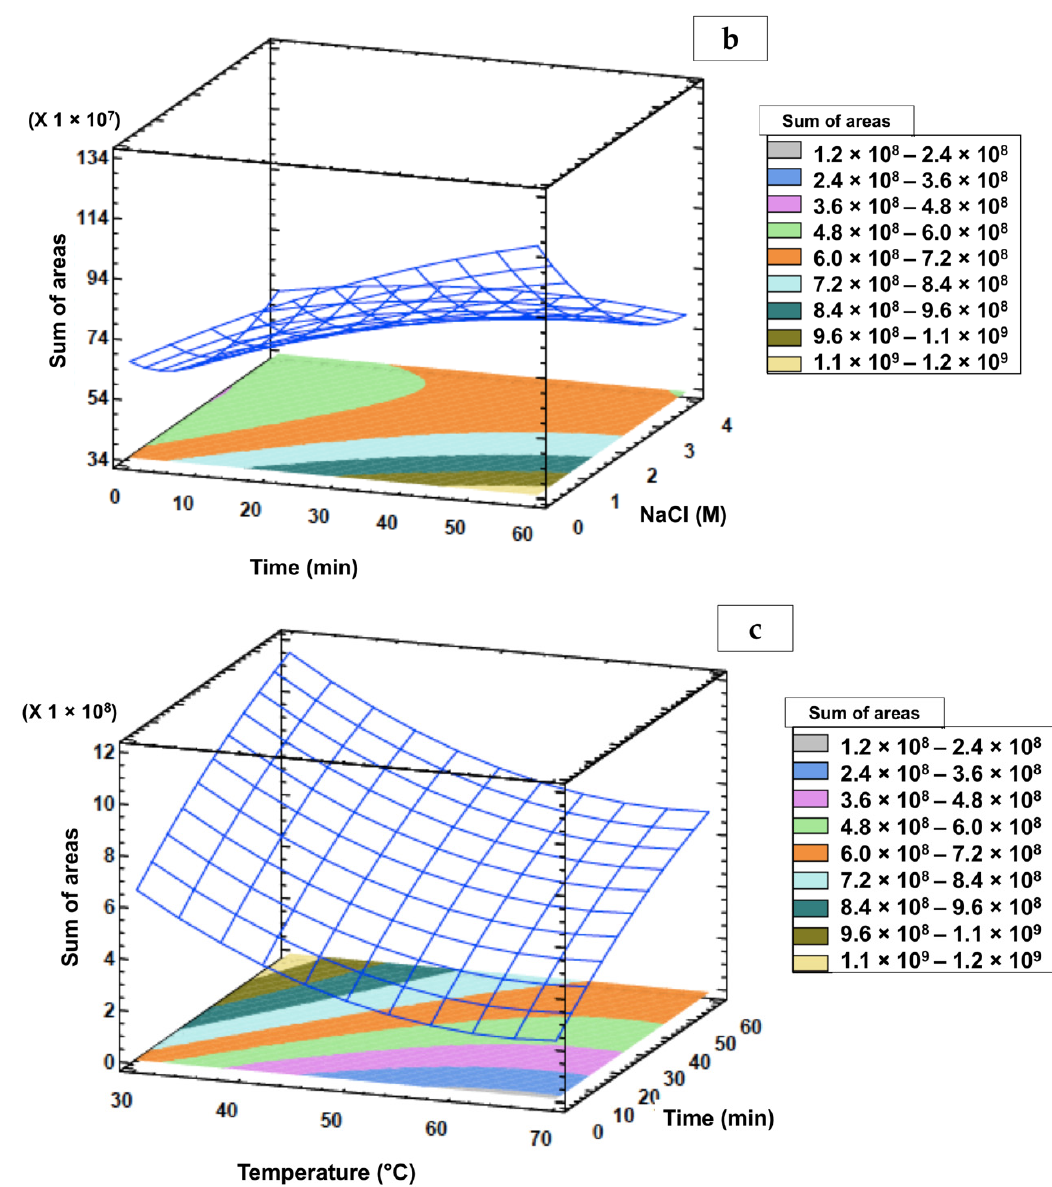
Figure 2. Response surface and contour plots showing interactions on the sum of areas values: ( a ): temperature vs. NaCl with fixed time at 60 min; ( b ) time vs. NaCl with the fixed temperature at 30 °C; ( c ) temperature vs. time with fixed NaCl at 0 M.